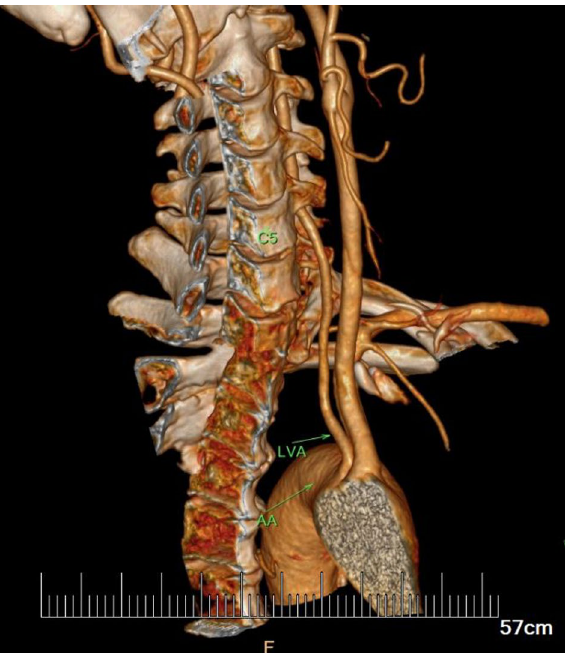
Figure 1. Typical case of subjects with LVA arising from aortic arch. The distal segment enters the transverse foramen at C5 level higher than normal.